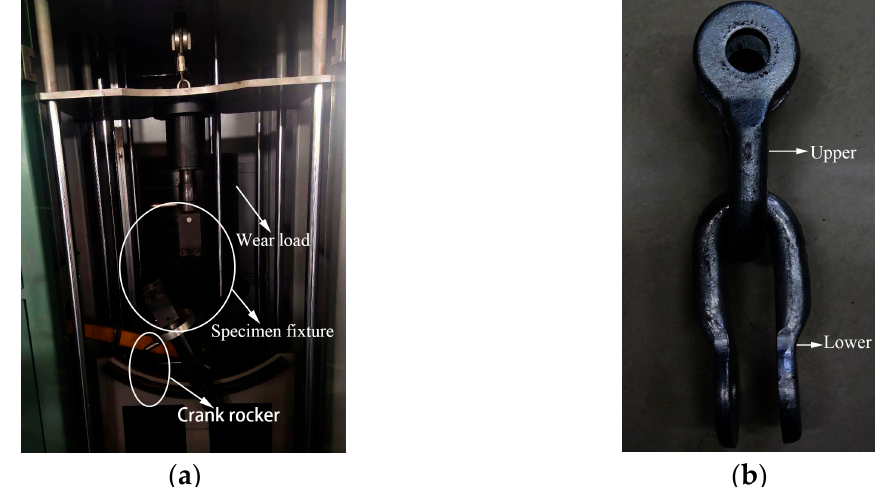
Figure 1. Upper and lower U-shaped ring, ( a ) wear tester; ( b ) U-shaped ring assembly image. Table 1. Chemical composition of the U-shaped ring (wt.%).